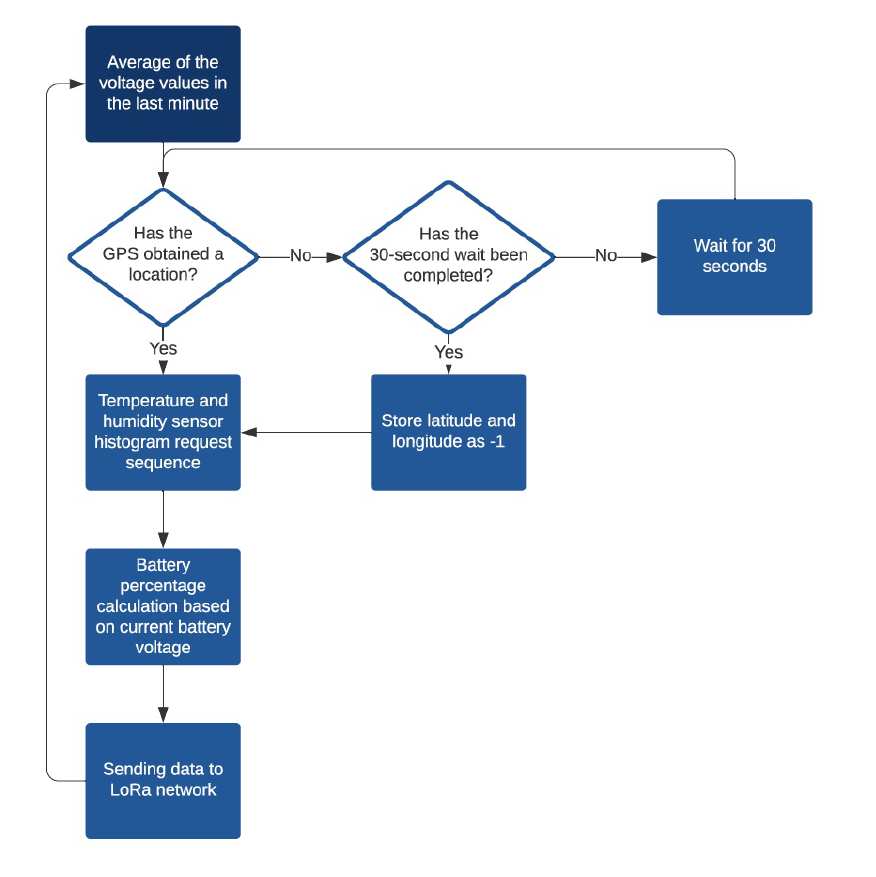
Figure 7. Flow diagram of the pollutant gas measuring device